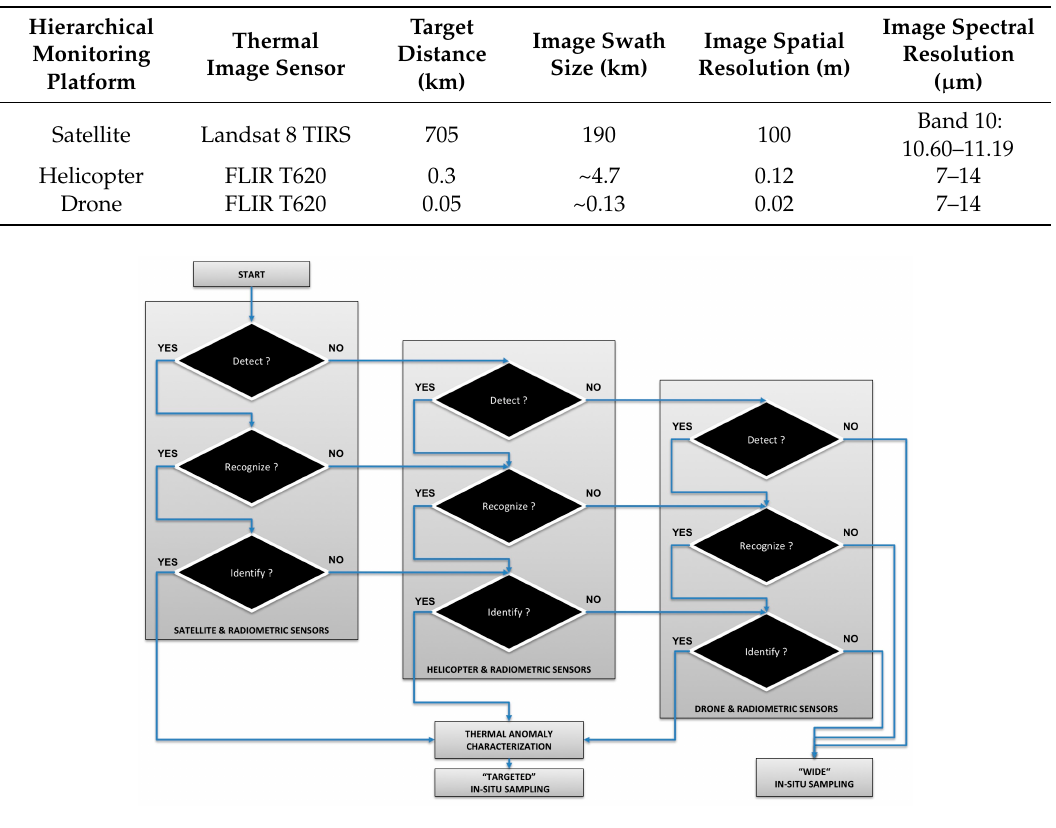
Figure 2. Flowchart illustrating the choice of platform in hierarchical monitoring, related to target detect, recognize, and identify criteria. All three platforms may be needed for a set of distinct targets.